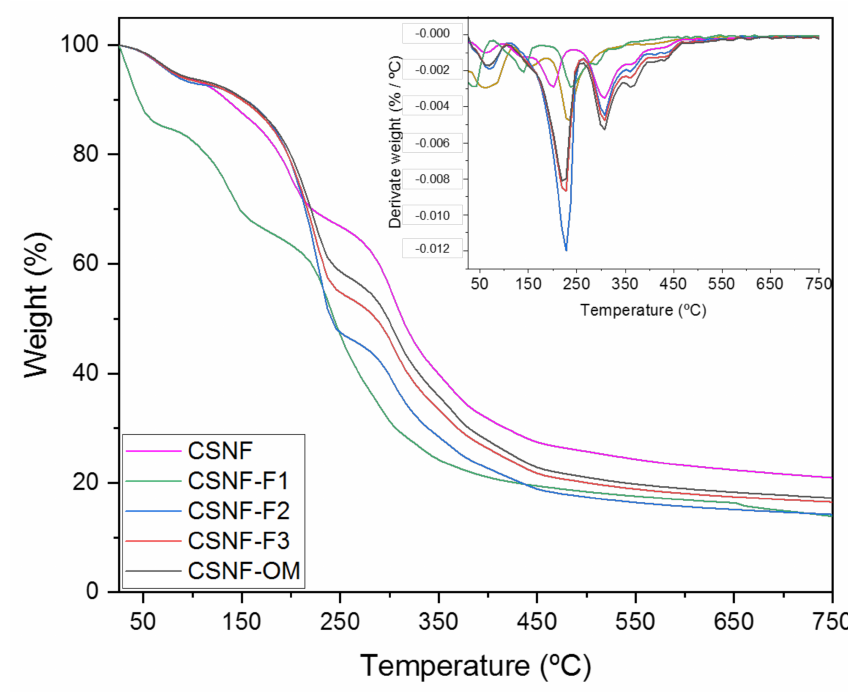
Figure 6. TGA and dTGA curves of the nanocomposite